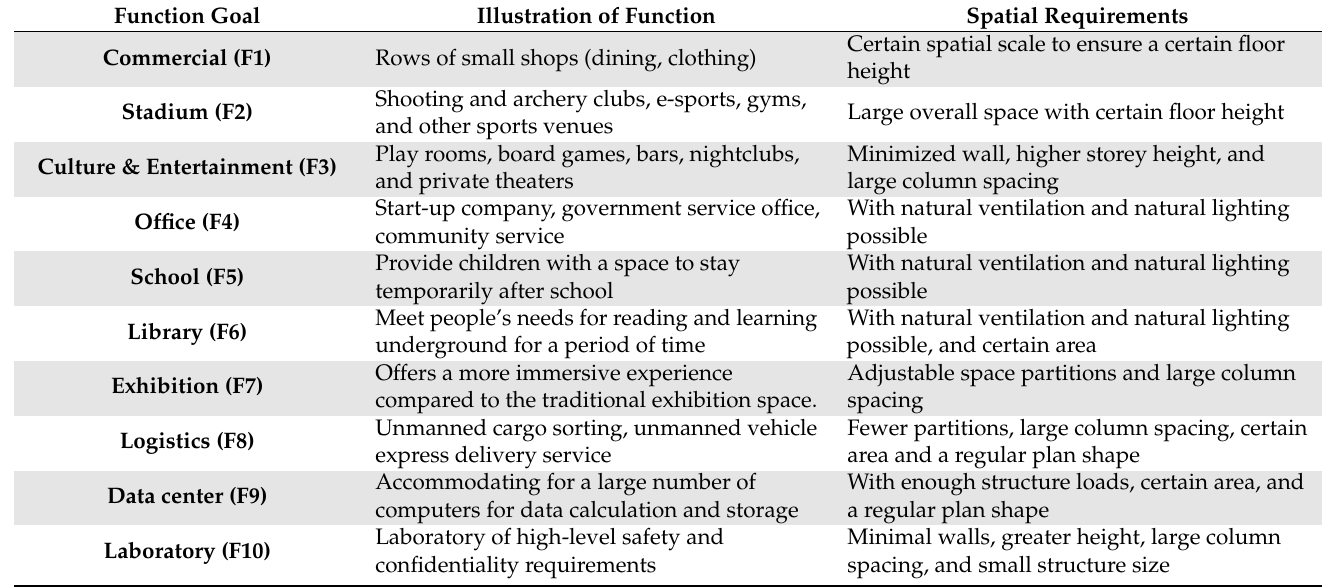
Table 3. Library of replacement